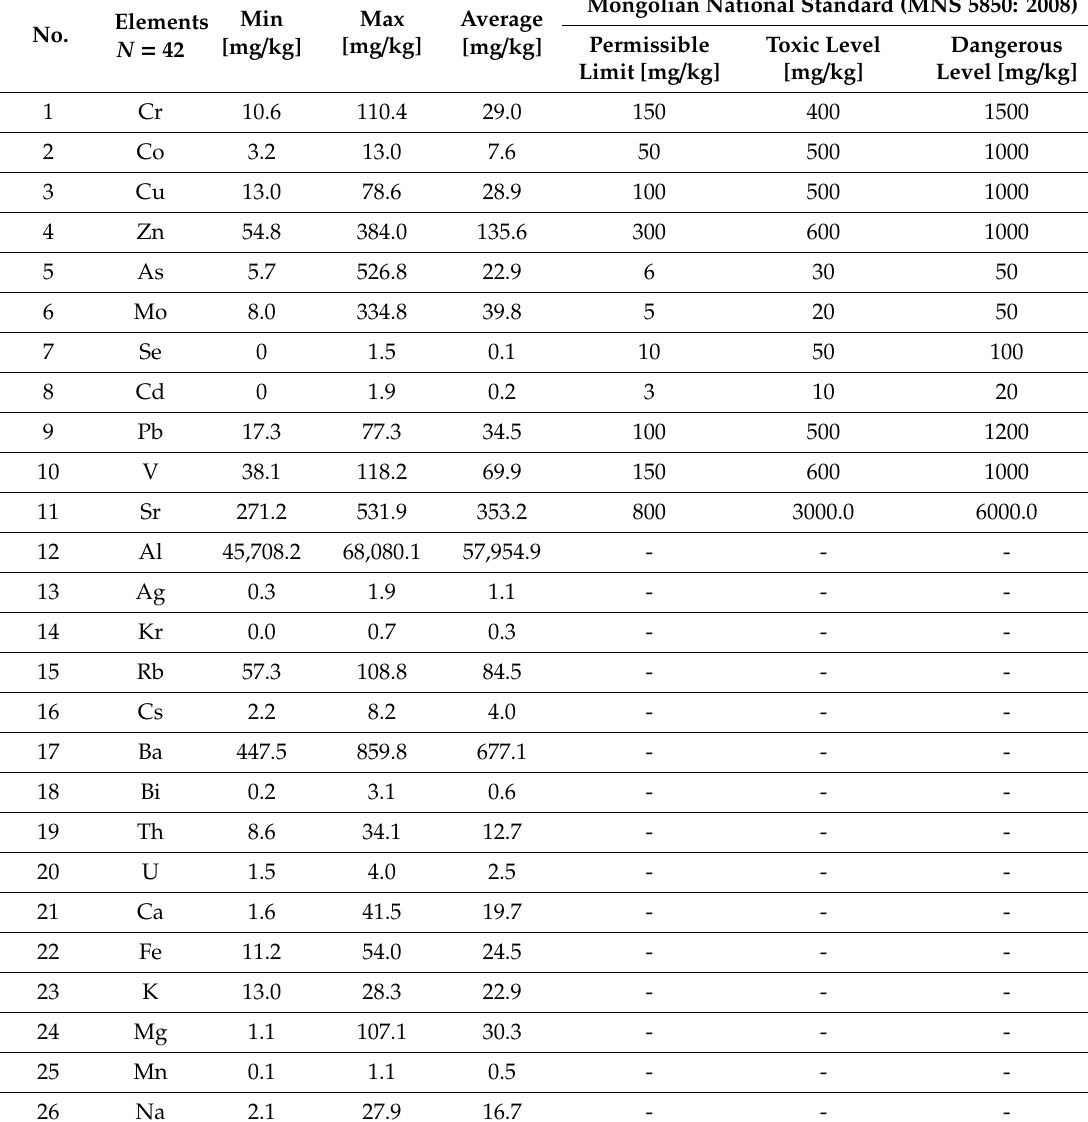
Table 8. Measurement results of heavy metal concentrations and Mongolian National Standard (MNS)